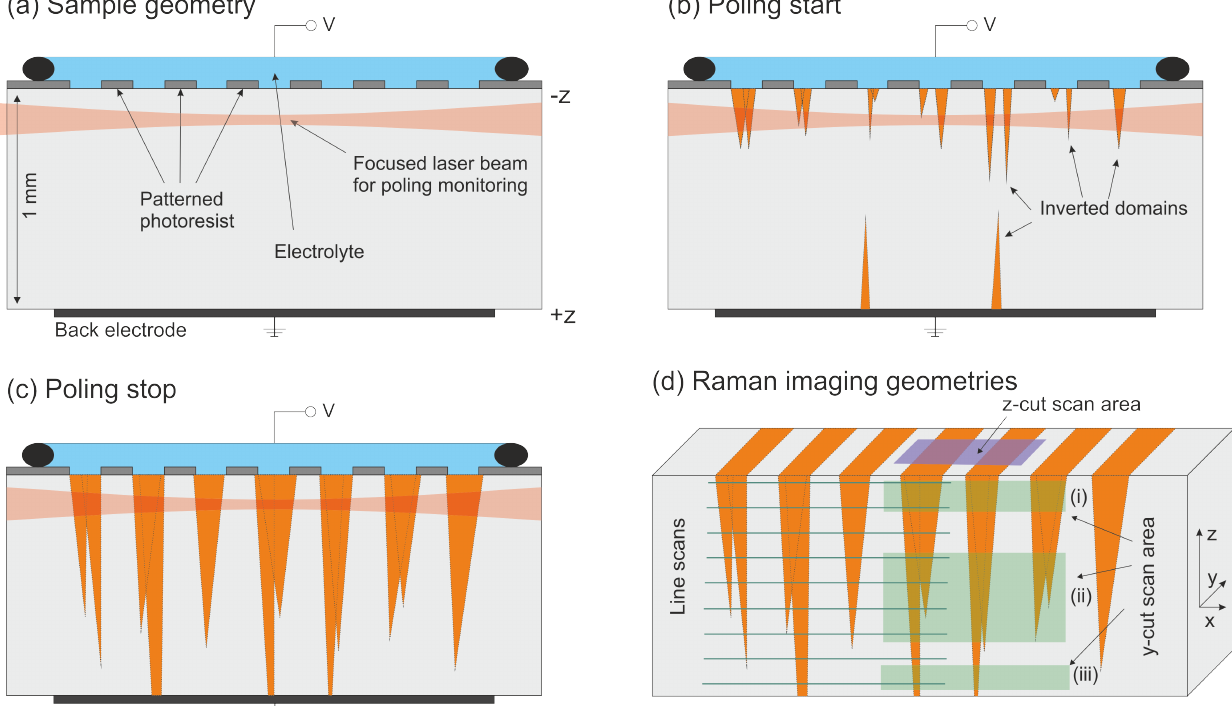
Figure 1. Principle sketch of: ( a ) Poling and monitoring geometry used in this study. ( b ) Poling start: With application of the first pulse over the coercive field, inverted domains will nucleate under the electrically contacted area. ( c ) Poling stop: After application of multiple pulses, the domains will have grown deeper and have merged until an approximately 50/50 duty cycle in the monitored regions is achieved. ( d ) Geometries for the presented Raman analysis. Figure is not to